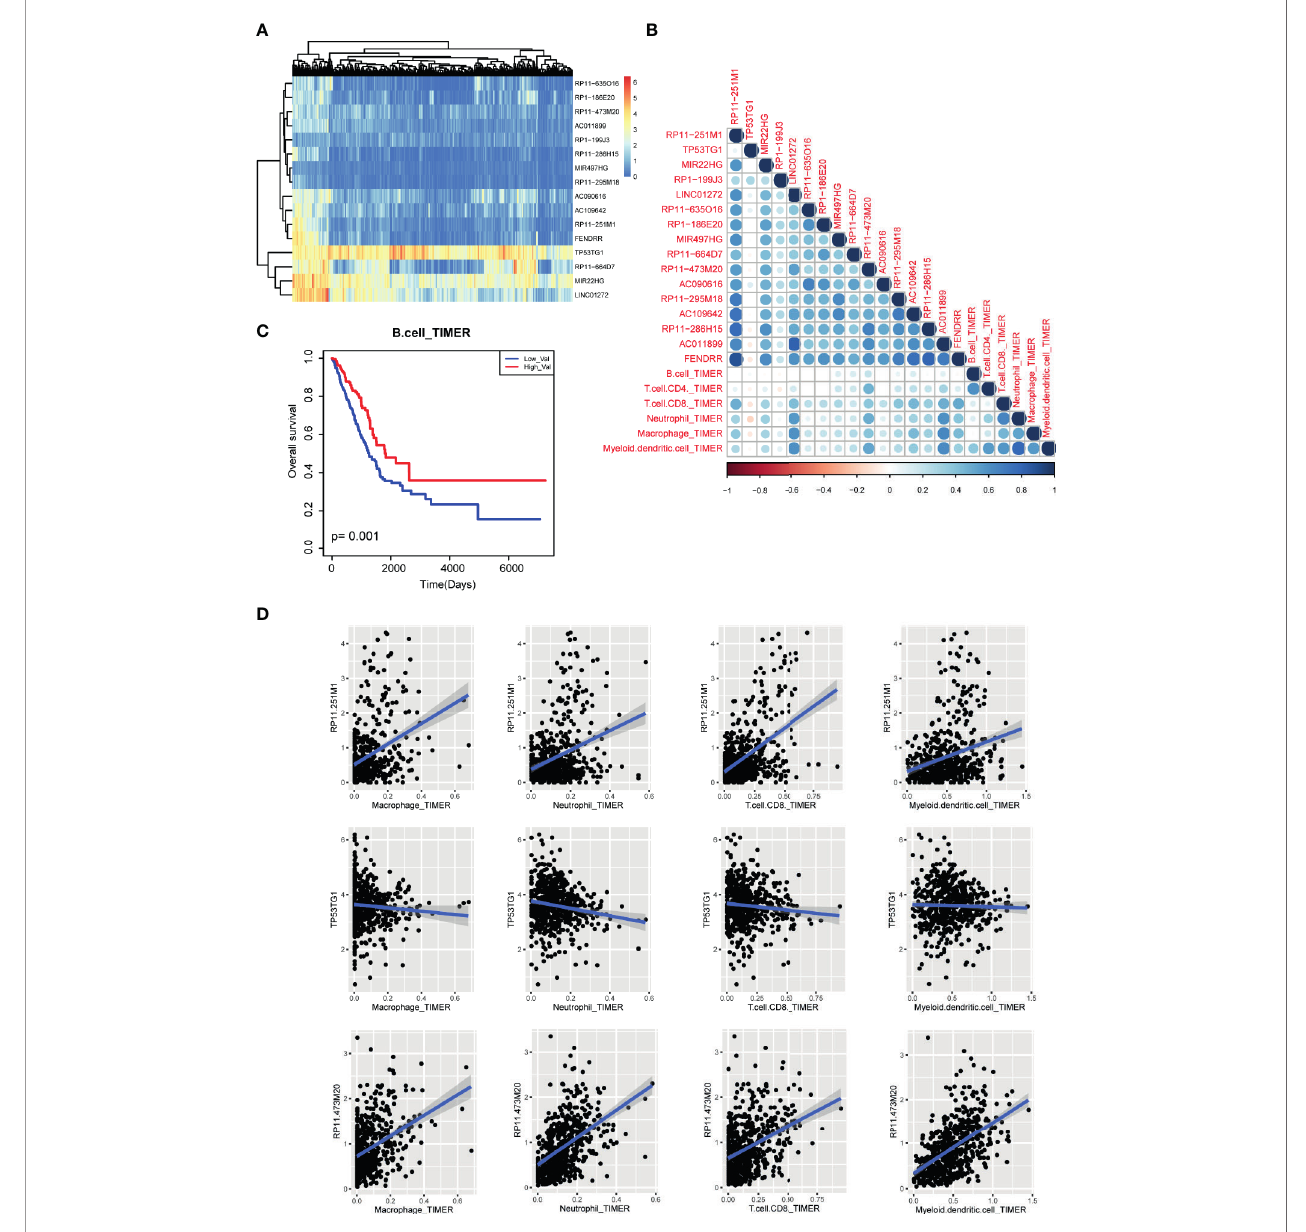
FIGURE 7 | Immune cell in fi ltration of m6A-related lncRNAs in LUAD patients. (A) The expression heatmap of m6A-related lncRNAs in TCGA LUAD cohorts. (B) The correlation heatmap of correlation coef fi cients between m6A regulator expression and TIMER2 immune cell estimation score. (C) The Kaplan-Meier survival curves of between B cell-enriched patients and other patients. (D) Scatter plots of correlations between m6A regulator expression and TIMER2 immune cell estimation